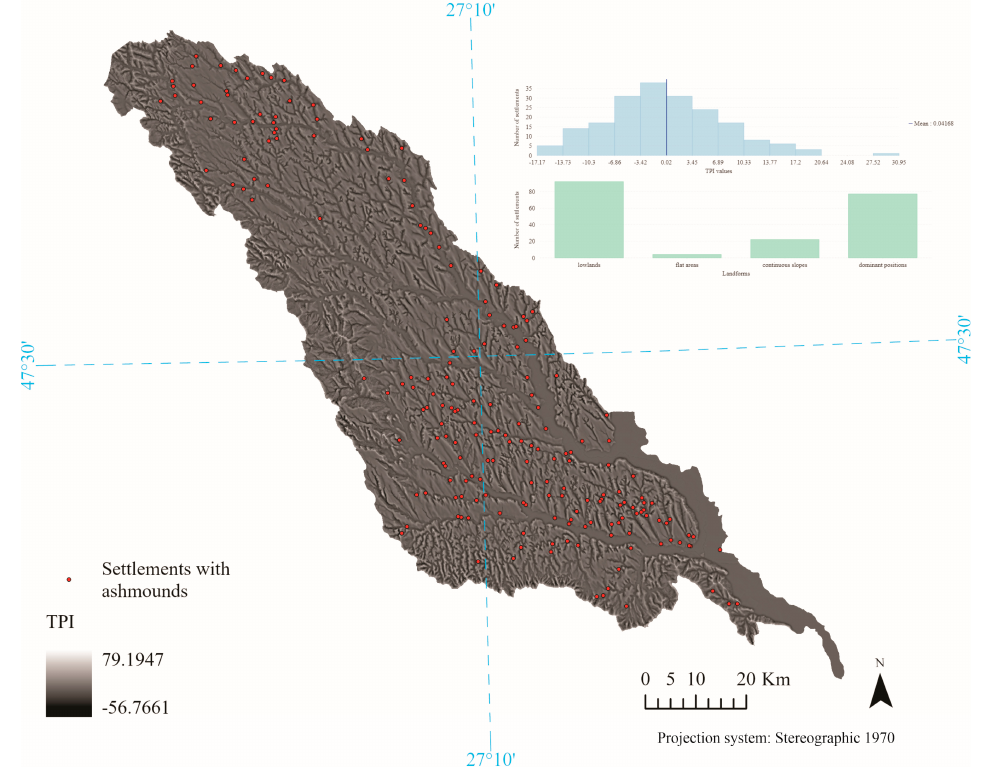
Figure 8. Noua settlements with ashmounds overlapped on TPI map, with graphs showing the TPI values of all the sites and their distribution within the main categories.